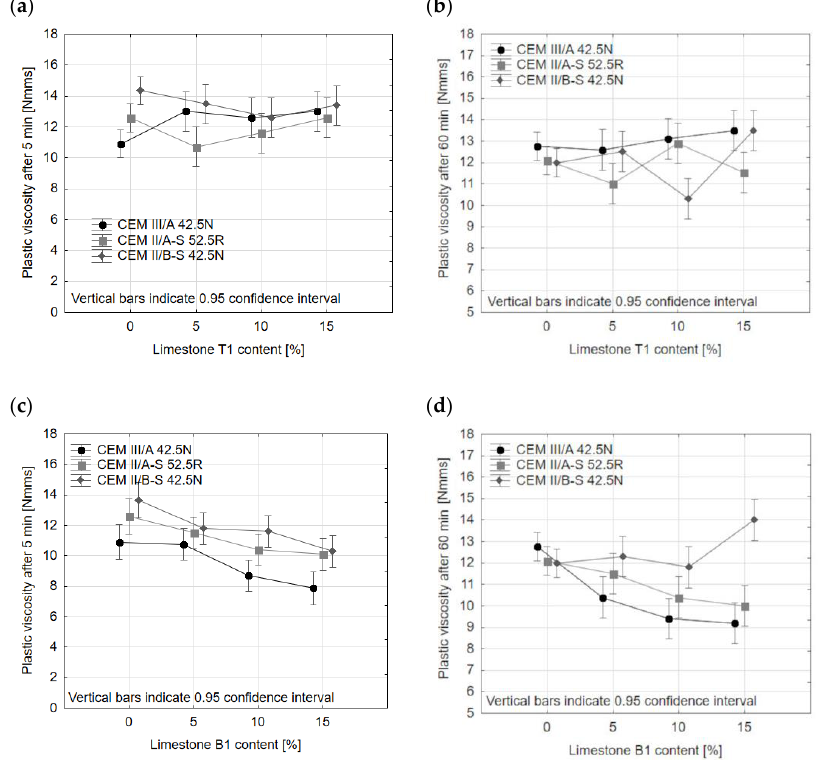
Figure 6. Plastic viscosity of slag-limestone cements after 5 min ( a , c ) ad 60 min ( b , d ) from the moment of mixing.